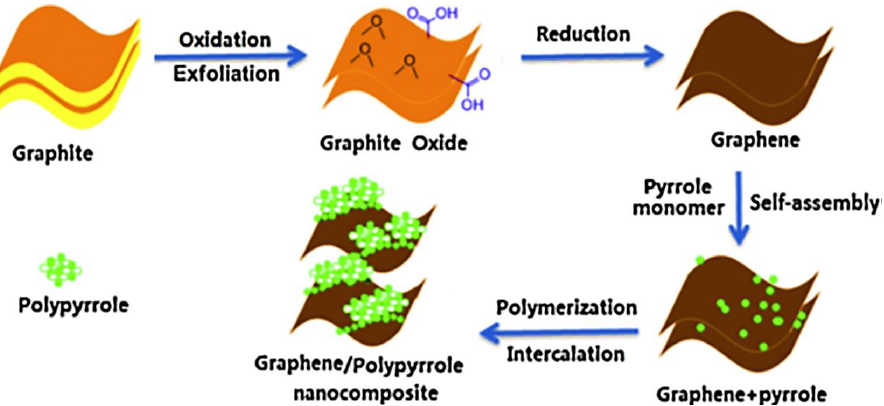
Figure 7. Synthesis of PPy/graphene nanocomposite [87]. PPy = polypyrrole. Reproduced with permission from Elsevier.